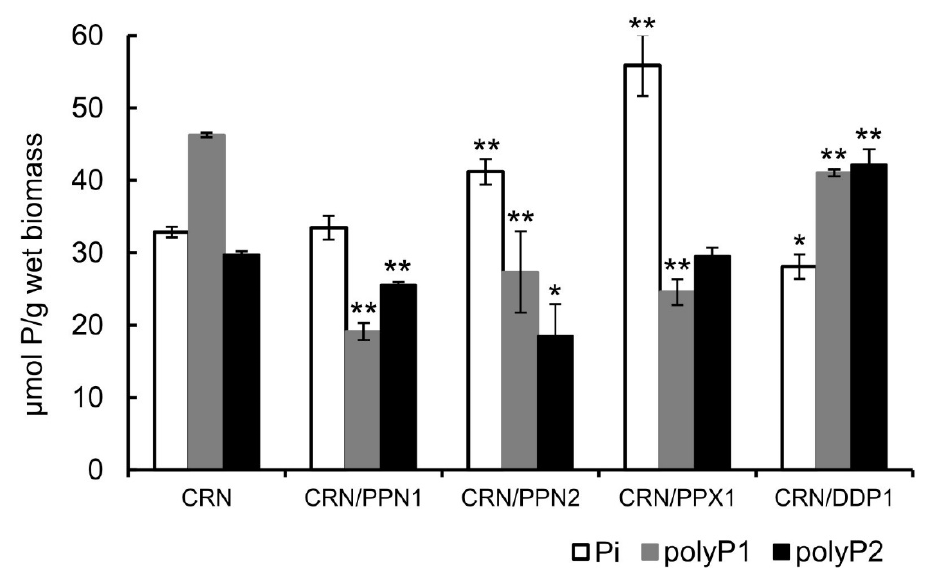
Figure 2. Pi (orthophosphate) and polyP content in cells of S. cerevisiae strains overexpressing polyphosphatases Ppx1, Ppn1, Ppn2, or Ddp1 and parent strain CRN. Cells were cultivated in YPD medium (2% glucose, 2% peptone, 1% yeast extract, w / v ) containing 3 mM Pi for 24 h at 29 ◦ C with shaking at 145 rpm. Acid-soluble polyP1 extracted from biomass with 0.5 M HClO4 at 0 ◦ C. Amount of acid-insoluble polyP2 remaining in the biomass was estimated by the phosphate released after 20 min treatment of biomass samples with 0.5 M HClO 4 at 100 ◦ C. Amount of polyP normalized to weight of biomass samples standardized by centrifugation at 5000 × g for 15 min (wet biomass). Statistical significance assessed against CRN with Student’s t -test: * p < 0.05, ** p < 0.01. Yeast polyphosphatases differ in subcellular localization. Ppx1 [27] and Ddp1 [29]